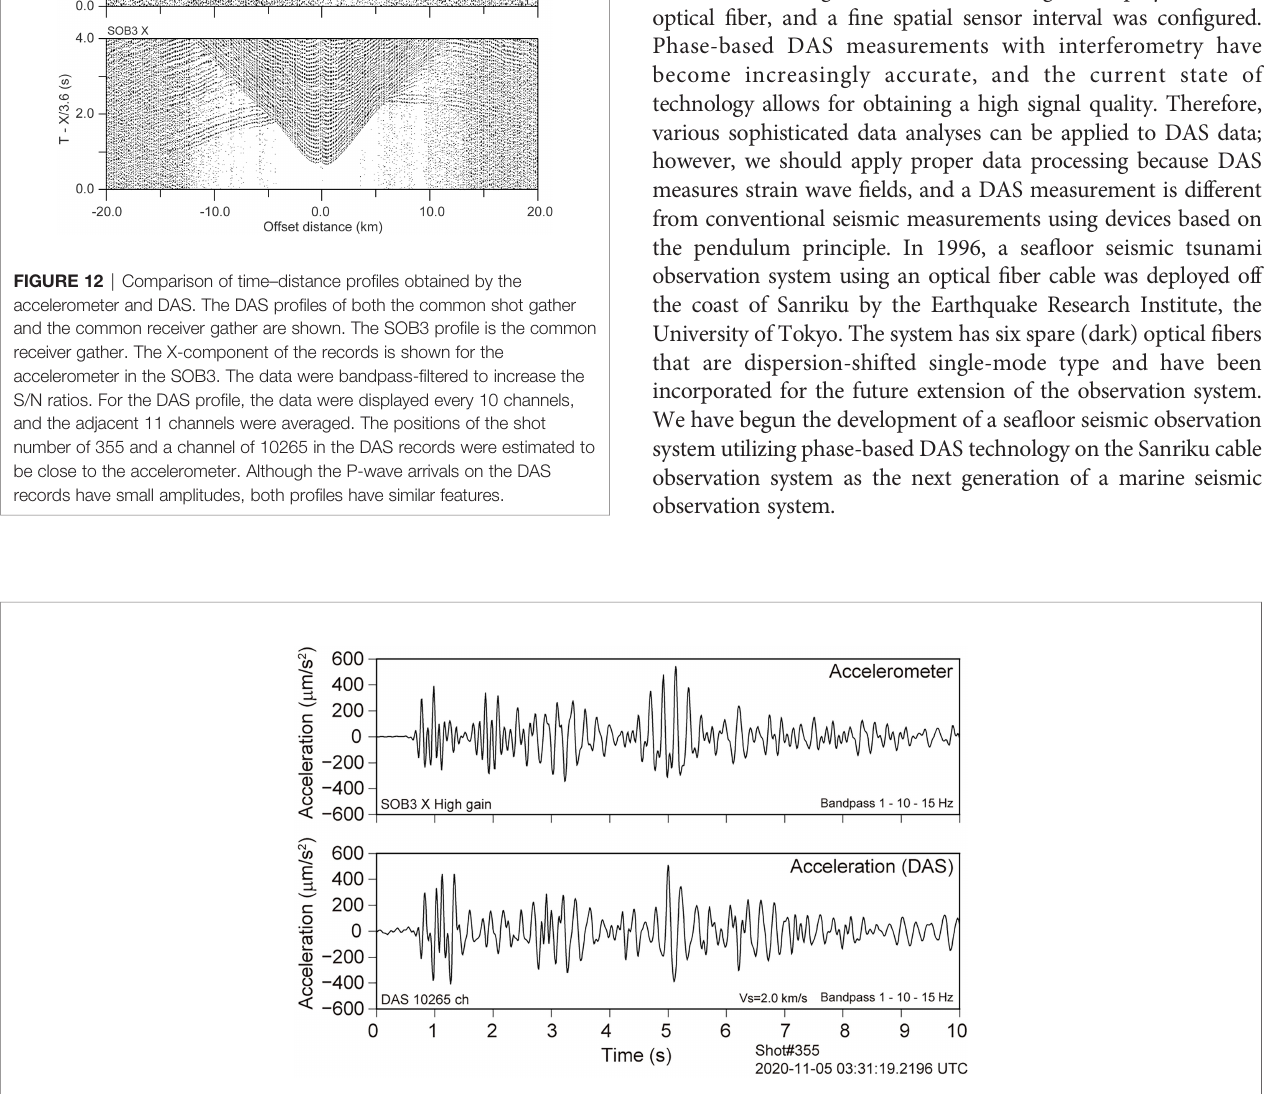
FIGURE 13 | Comparison of the DAS records and SOB3 records for airgun signals (Shot No. 355). The airguns were positioned just above the SOB3. The data from the DAS measurement were converted to acceleration with a wave propagation velocity of 2.0 km/s (lower) to compare the X-component data from the accelerometer (upper). The adjacent 11 channels of the DAS records were averaged. The position of the 10265 channel was estimated to be close to the SOB 3. Both records were fi ltered from 1 to 10